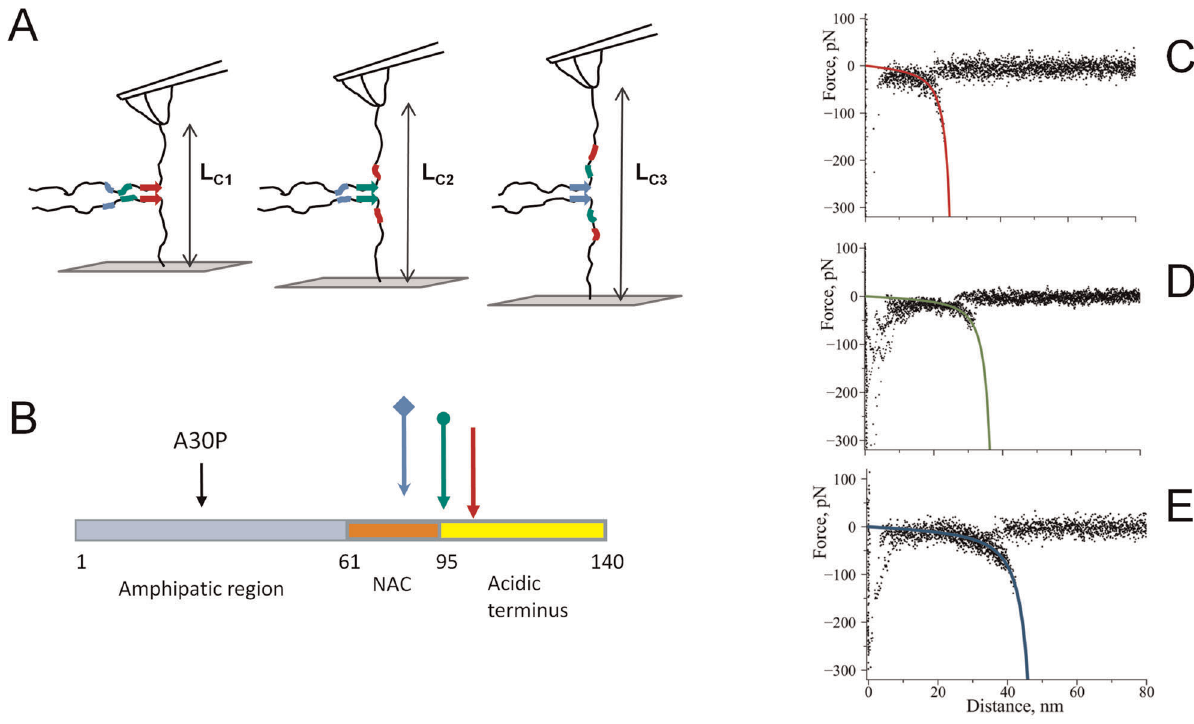
Figure 6. Interaction model of alpha-synuclein molecules. The model describes three major peaks in the contour length histograms as identical sites in each monomer interacting with each other with the formation of a dimer. A) Position of the interacting site further from the C- terminus (point of attachment) results in longer contour length value. B) Positions at the beginning of the detected interaction sites. Colored arrows correspond to three detected interaction sites schematically shown in A), and the black arrow shows the position of the A30P mutation in alpha- synuclein; C), D) and E) superposition of representative force-distance curves for the detected rupture events corresponding to L C1 , L C2 and L C3 , red, green and blue lines on the graphs are WLC curves calculated with L C values from Fig.